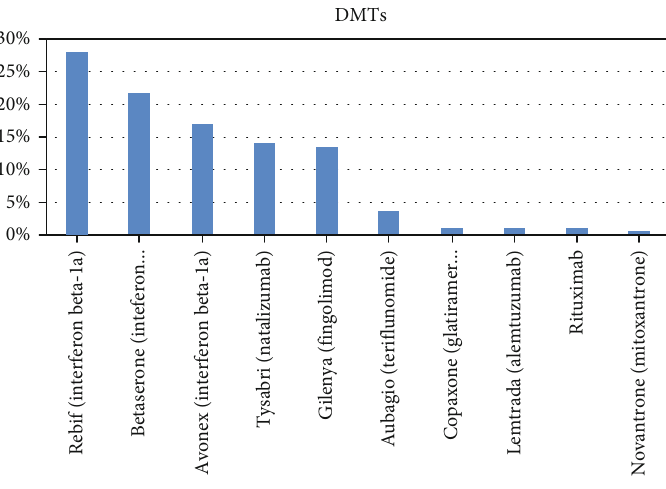
Figure 2: DMTs among patients with pediatric onset of MS ( n = 232 ). Table 5: Family history of MS among individuals with pediatric onset of MS ( n = 287